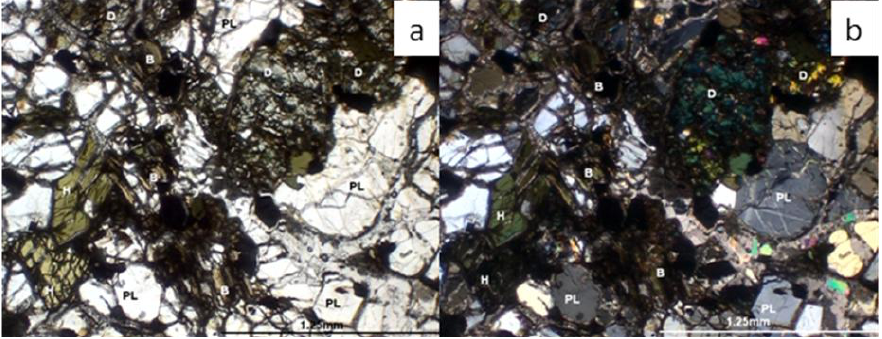
Figure 3: Photo micrographs showing biotite (B), hornblende (H), diopside (D) and plagioclase in weathered rock under plane polarized light ( a ) and cross polarized light (b)